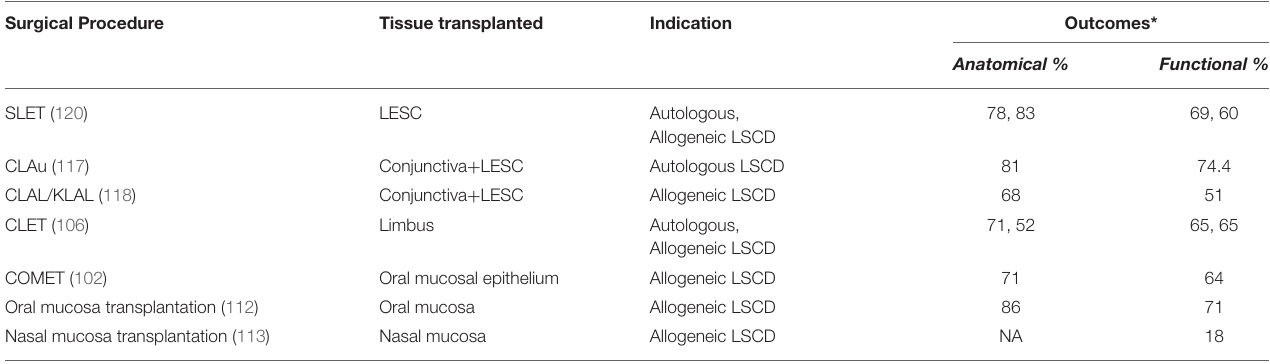
TABLE 6 | Comparison of indications and outcomes of different surgical modalities of management of limbal stem cell deficiency. Surgical Procedure